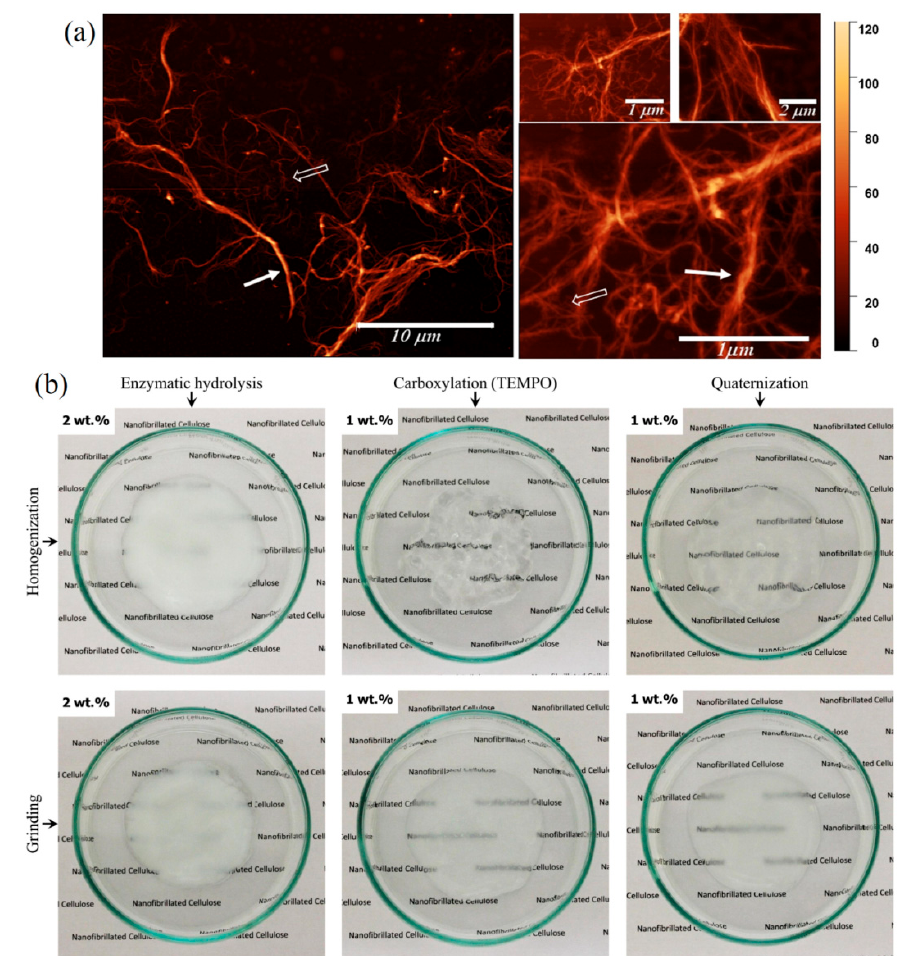
Figure 6. ( a ) AFM images of NFCs. ( b ) Top view images of NFC suspensions placed in Petri dishes produced using different processing conditions. Reprinted from reference ( a ) [92] and ( b ) [89] with permission from Elsevier.